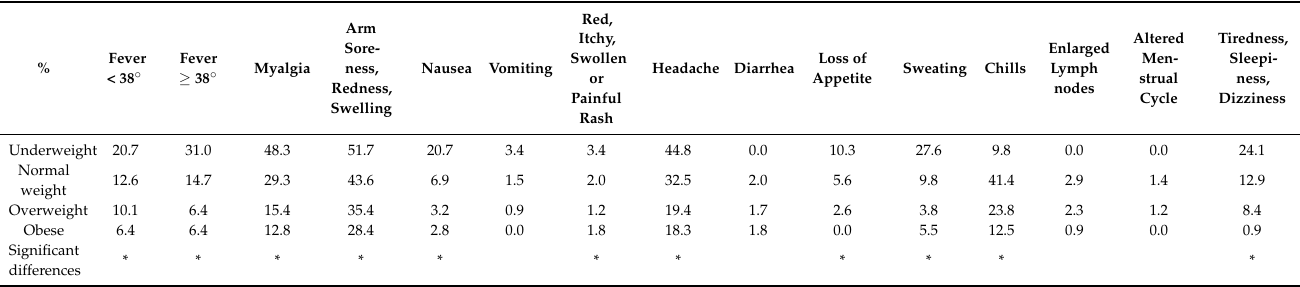
Table 3. Crosstabs of side effects after receiving the first dose of the vaccine against COVID-19 per weight status (in percentage).